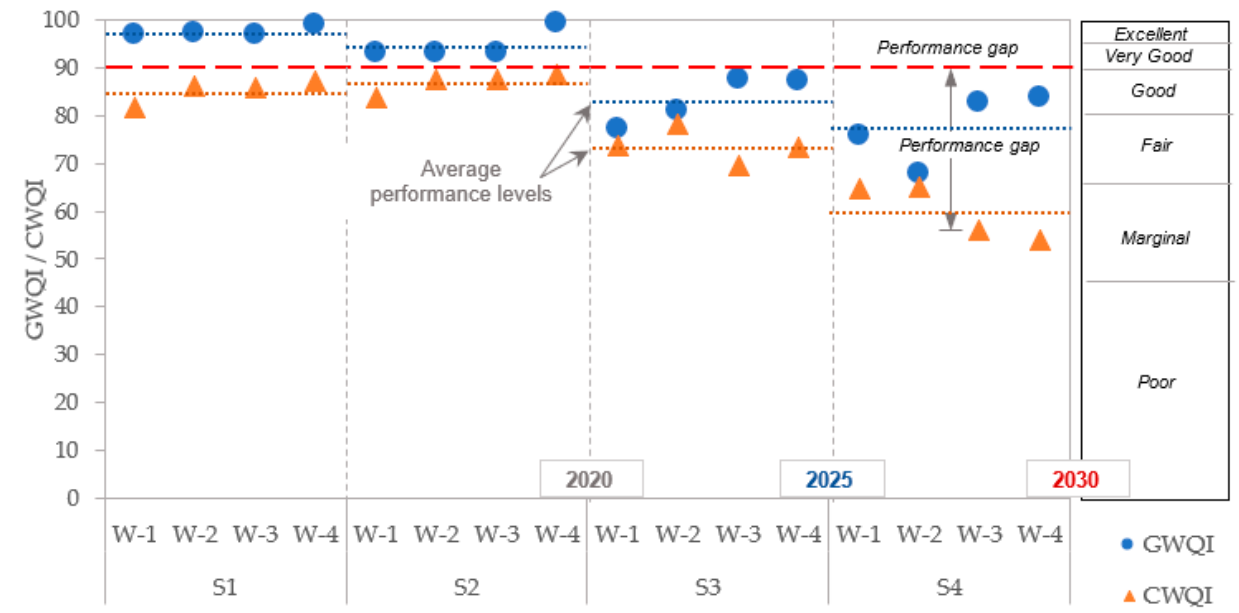
Figure 4. GWQI, CWQI, and identification of performance gap for CPI. S—Existing scenario for reuse of treated wastewater for restricted irrigation, S2—Existing scenario for reuse of treated wastewater for unrestricted irrigation, S3—Cycle 1 for CPI for reuse of treated wastewater for fish and livestock drinking, S4—Cycle 1 for CPI for reuse of treated wastewater for fish and recreation. Note: “W” in the figure denotes wastewater treatment plant.